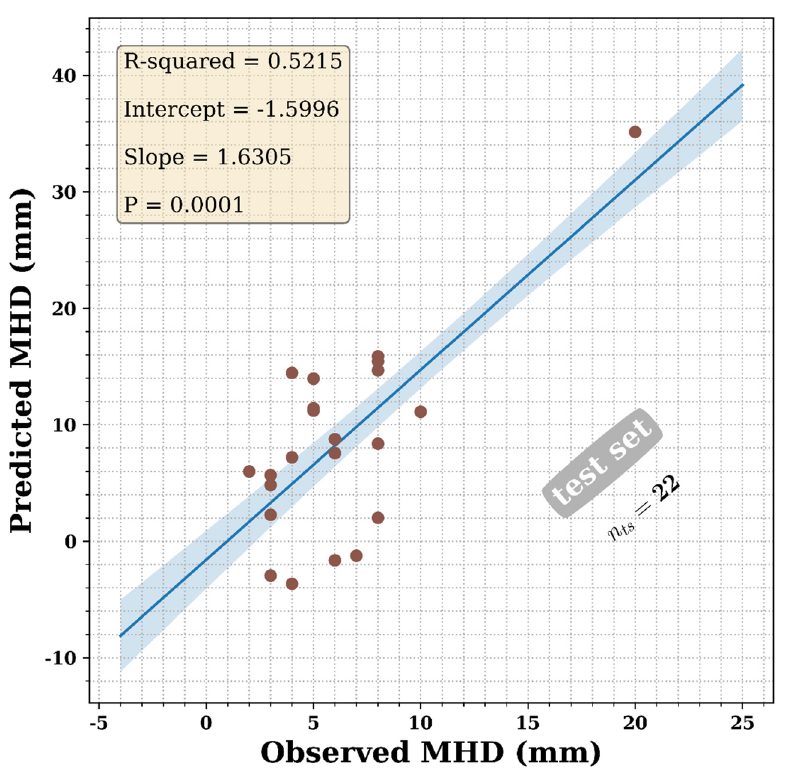
Figure 6. Linear fitting of predicted vs. observed MHDs on the test set. The sample size is 22 ( n ts = 22). The text box at the top left displays the R-squared, the intercept (Intercept) and slope (Slope) values, and the P-value that indicates the confidence interval is 95%. Table 5. Comparisons of data, methods, and R-squared on the test set between different maximum hail diameter (MHD) estimation models.